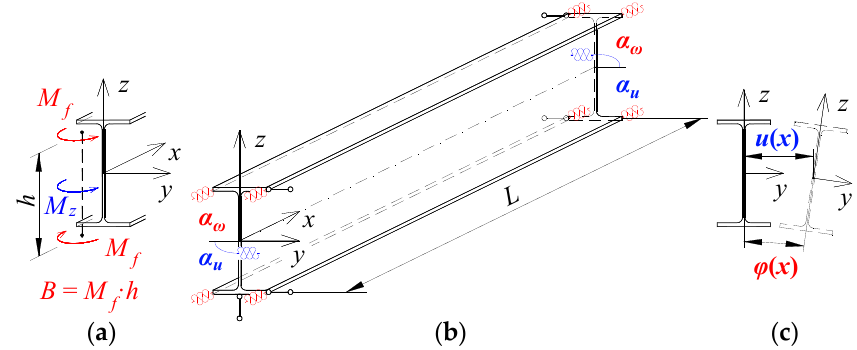
Figure 1. Static diagram of the beam: ( a ) bimoment ( B ) and moment ( M z ) at the support, ( b ) elastic restraint against warping ( α ω ) and against lateral rotation ( α u ), ( c ) twist angle ϕ ( x ) and lateral deflection u ( x ).